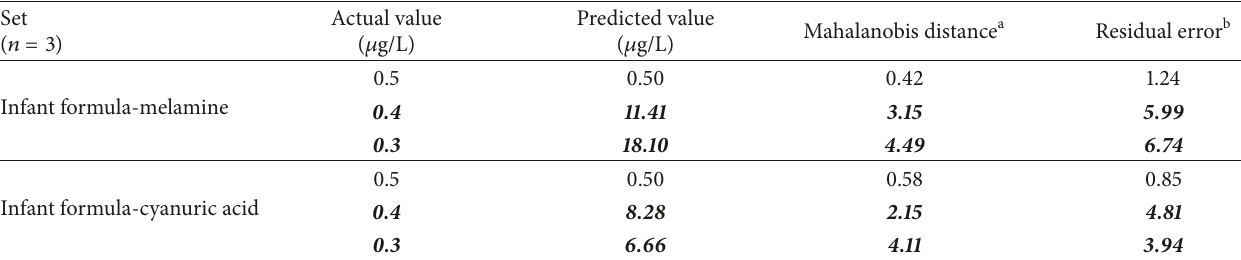
Figure5:Three-dimensionalprincipalcomponentanalysisscoresplotofthepopulationsderivedfromSIMCA:infantformulapowder,infant formula powder with melamine, and infant formula powder with cyanuric acid. Table 3: Detection limits of melamine and cyanuric acid in infant formula powder by PLS1 models.